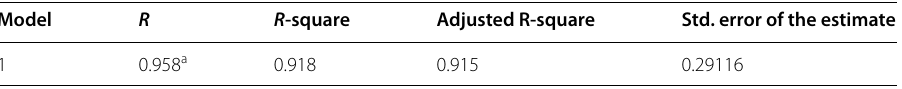
a Predictors (constant), national b Dependent variable: site characteristic